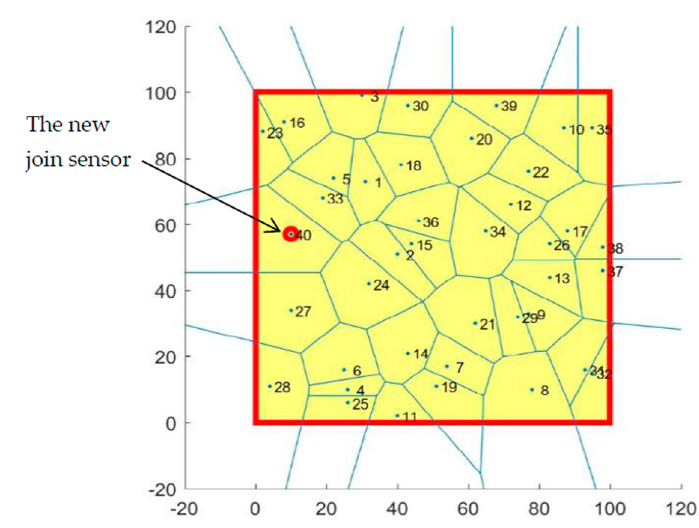
Figure 12. The distribution of the new sensors in the monitoring area network.